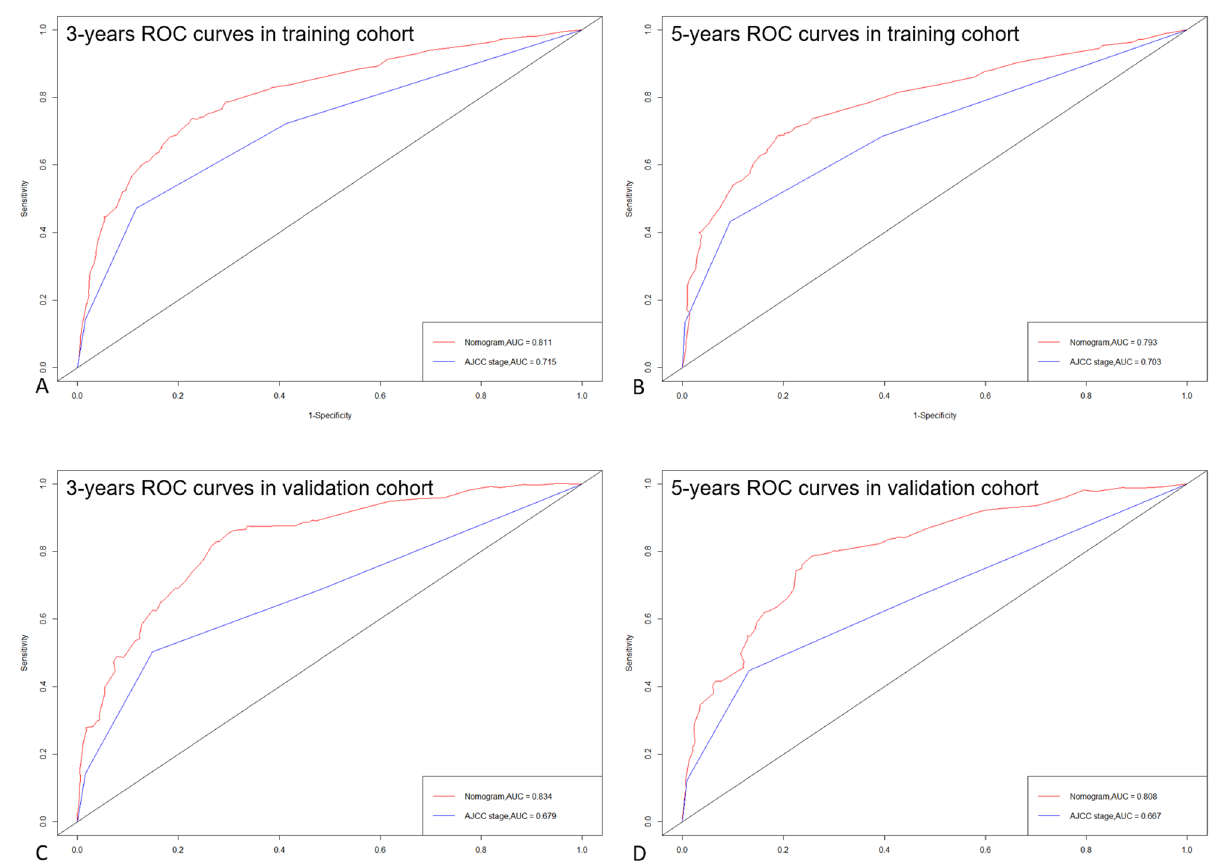
Figure 2. ROC curves of the Nomogram and AJCC stage in prediction of prognosis at 3- ( A ) and 5-year ( B ) point in the training cohort. ROC curves of the Nomogram and AJCC stage in prediction of prognosis at 3- ( C ) and 5-year ( D ) point in the validation